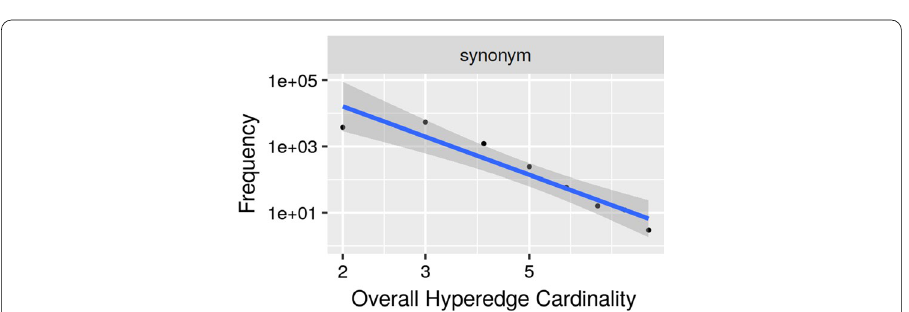
Fig. 12 WordNet 3.0 noun synonyms distribution (log–log scale)